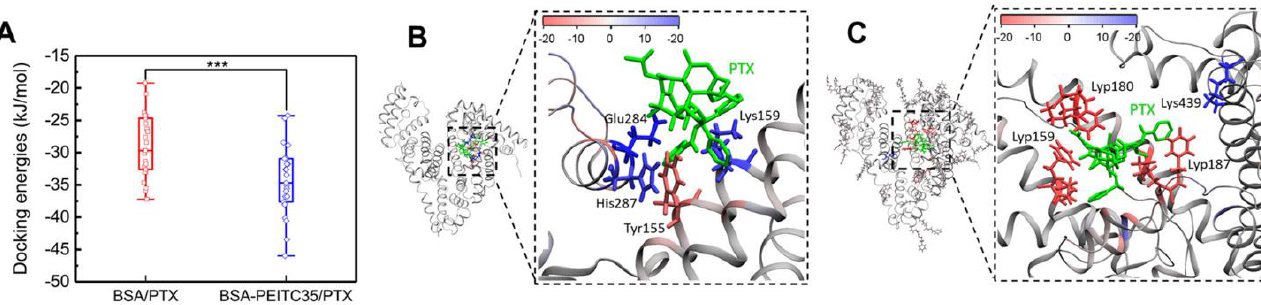
Figure 5. Binding mechanisms described by BSA/PTX (blue) and BSA-PEITC35/PTX (red) lowest binding energies ( A ) and respective snapshots ( B , C ). Reprinted from [65], copyright 2019, with permission from Elsevier.